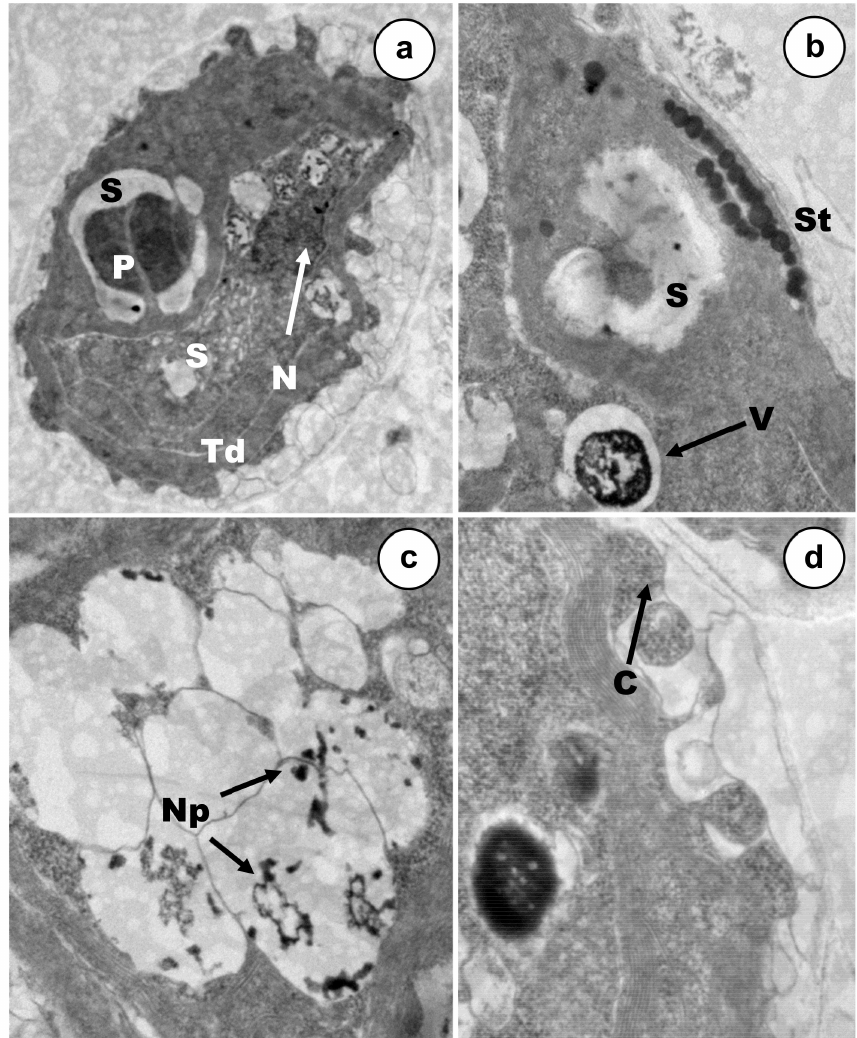
Figure 3. TEM micrographs of cells exposed to Cd 0.5 µ M. ( a ) General appearance of a treated cell (15k × ). ( b ) Detail of pyrenoid, stigma, and cell vacuole (50k × ). ( c ) Nanoparticles-like inside vacuoles (60k × ). ( d ) Discharge of exopolymers on cellular surface (60k × ). NP—Nanoparticles-like; S—starch deposits; P—pyrenoid; St—stigma; V—vacuole; Td—thylakoids;